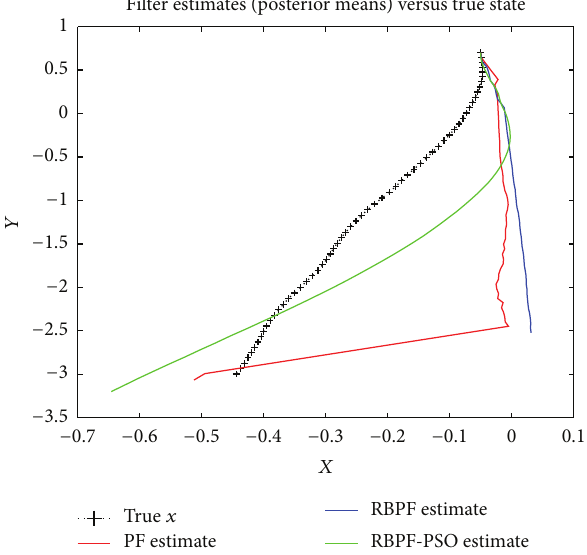
Figure 2: The estimates of different particle filters when the RBPF